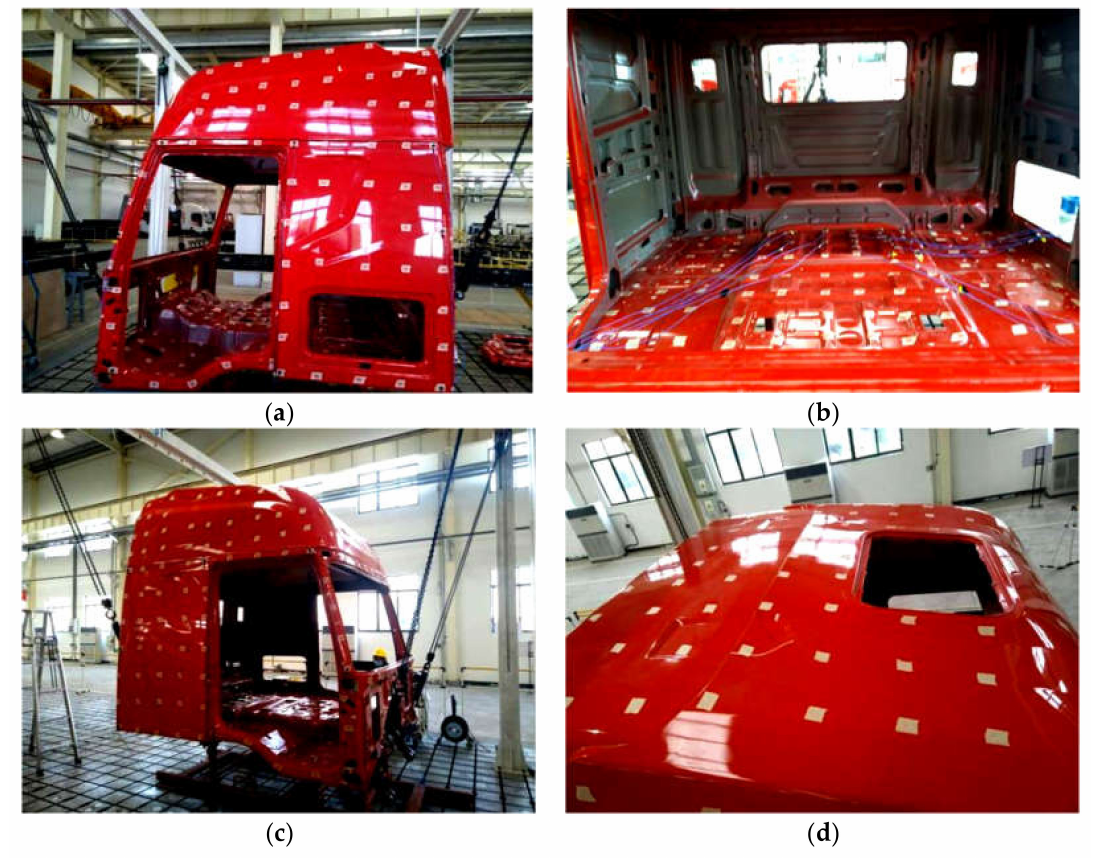
Figure 5. The layout of modal density measurement points. ( a ) Side measurement point of the cab; ( b ) Floor measurement point of the cab; ( c ) Modal test table of the cab; ( d ) Roof measurement point of the